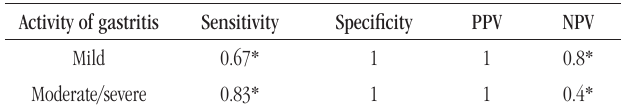
taBLE 2 − Sensitivity, specificity, PPV and NPV of HE stain in relation to Giemsa stain for the identification of Hp in chronic gastritis with mild and patent inflammatory activity Activity of gastritis